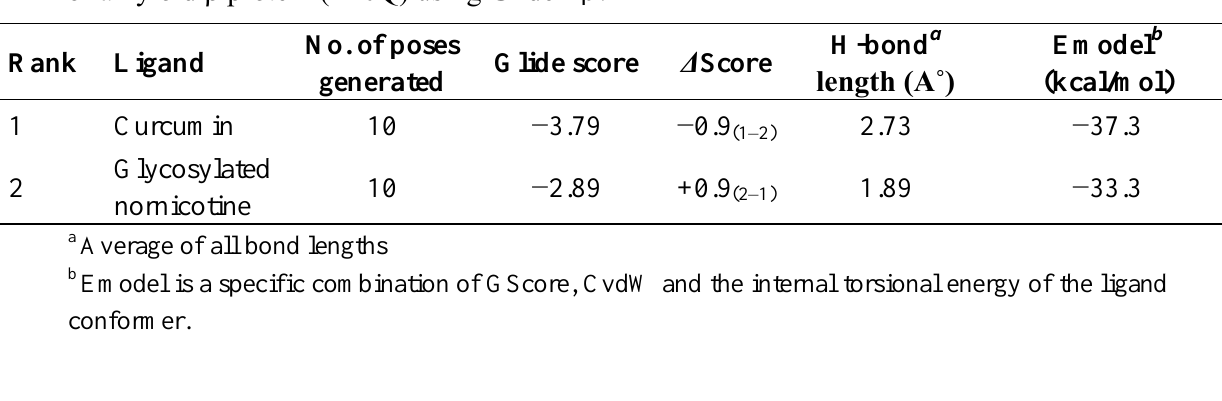
Table 5. Docking results of curcumin and glyconornicotine in the original crystal structure of amyloid β protein (1Z0Q) using